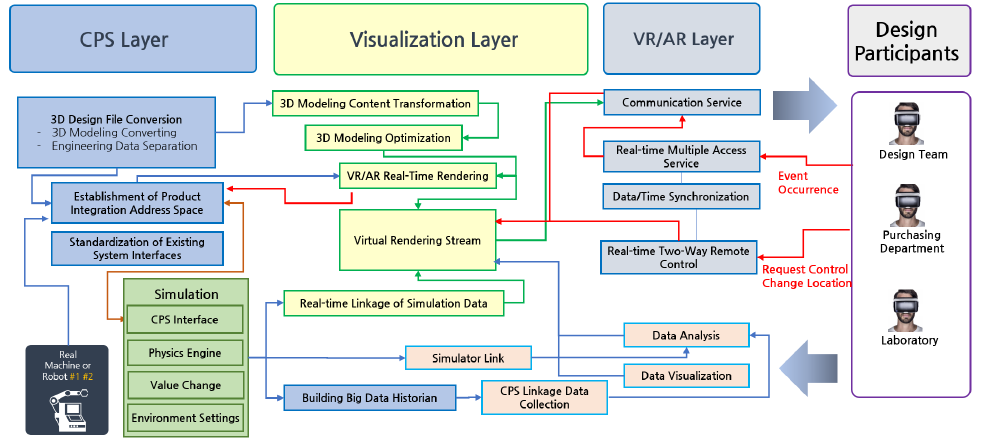
Figure 1. VR/AR collaboration model construction